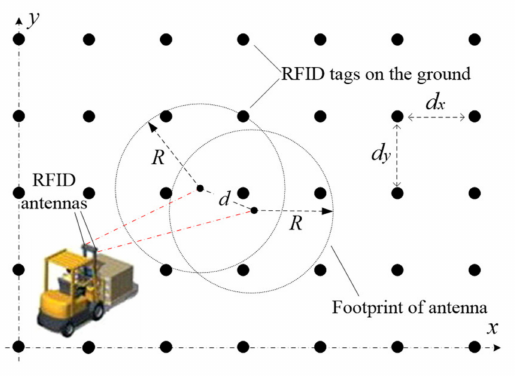
Figure 1. Indoor positioning of dual-antenna RFID